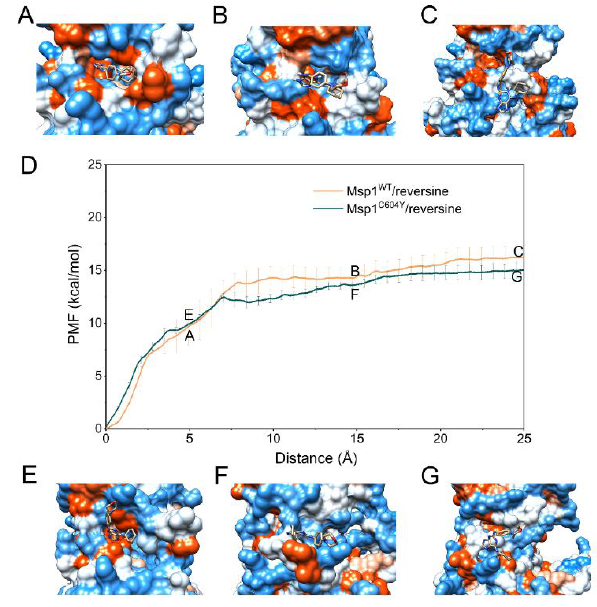
Figure 8. Alignment of the PMFs for reversine dissociate from Mps1 WT and Mps1 C604Y .